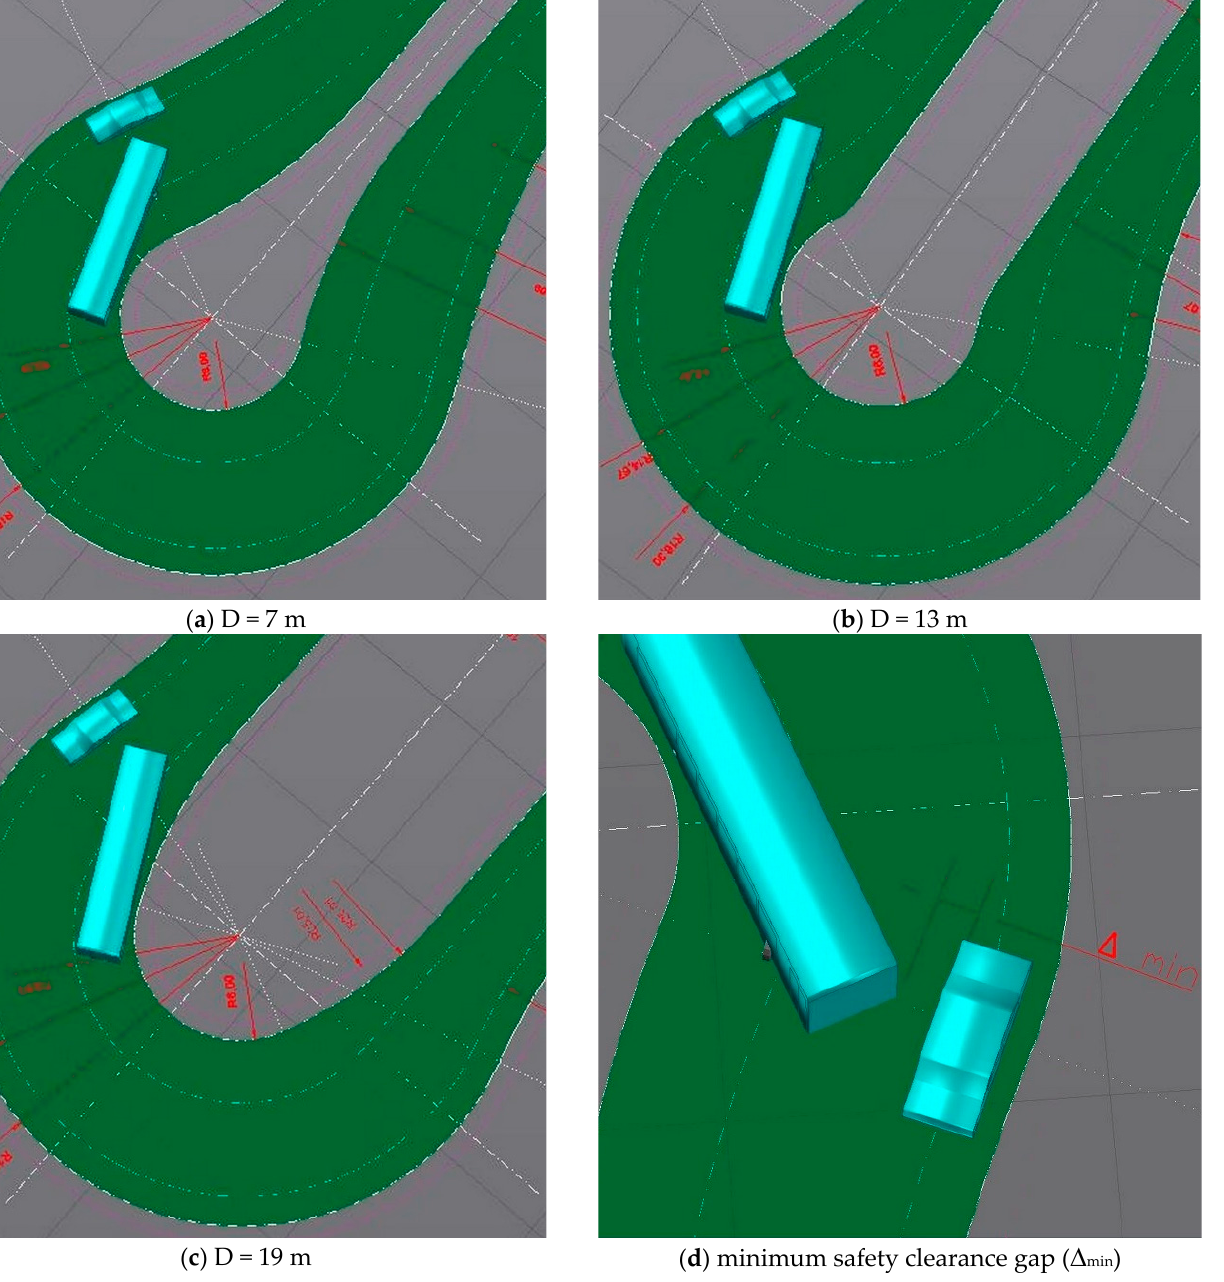
Figure 5. Critical point and minimum safety clearance gap ( ∆ min